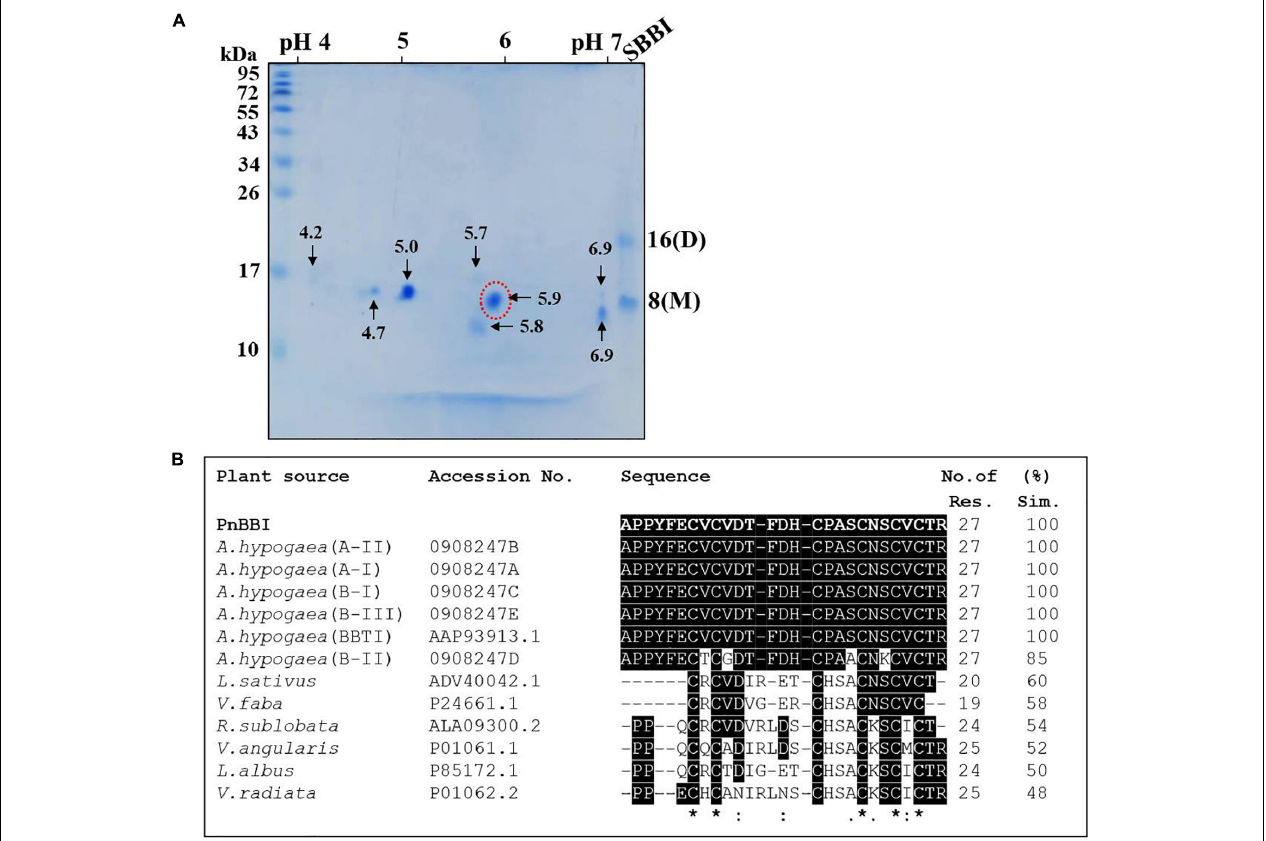
FIGURE 3 | 2-D electrophoresis and MALDI TOF-TOF analysis of PnBBI. (A) Isoelectric focusing (pH 4-7, 11 cm, L) of PnBBI (70 µ g) was performed under standard reducing conditions as described in methods (Section “Two-Dimensional Gel Electrophoresis (2-DE)”). The second dimension was performed on SDS-PAGE (15%) under reducing conditions and the gel was stained with CBB R-250. Molecular mass standards and soybean BBI were used as a reference and positive control, respectively. The 2-DE gel picture shown is the representative of three biological replicates; (B) The isoinhibitor spot with pI 5.9 (indicated by a dotted circle of Figure 3A ) was subjected to trypsin digestion followed by MALDI TOF-TOF analysis. The resulting peptide sequence from Mascot MS/MS ions search was aligned with the homologous BBI sequences of NCBI database using Clustal Omega tool. The obtained sequence has shown 100% identity with peanut BBI. The gel picture shown here is the selective representation of three biological replicates (data provided as Supplementary Data Sheet 3